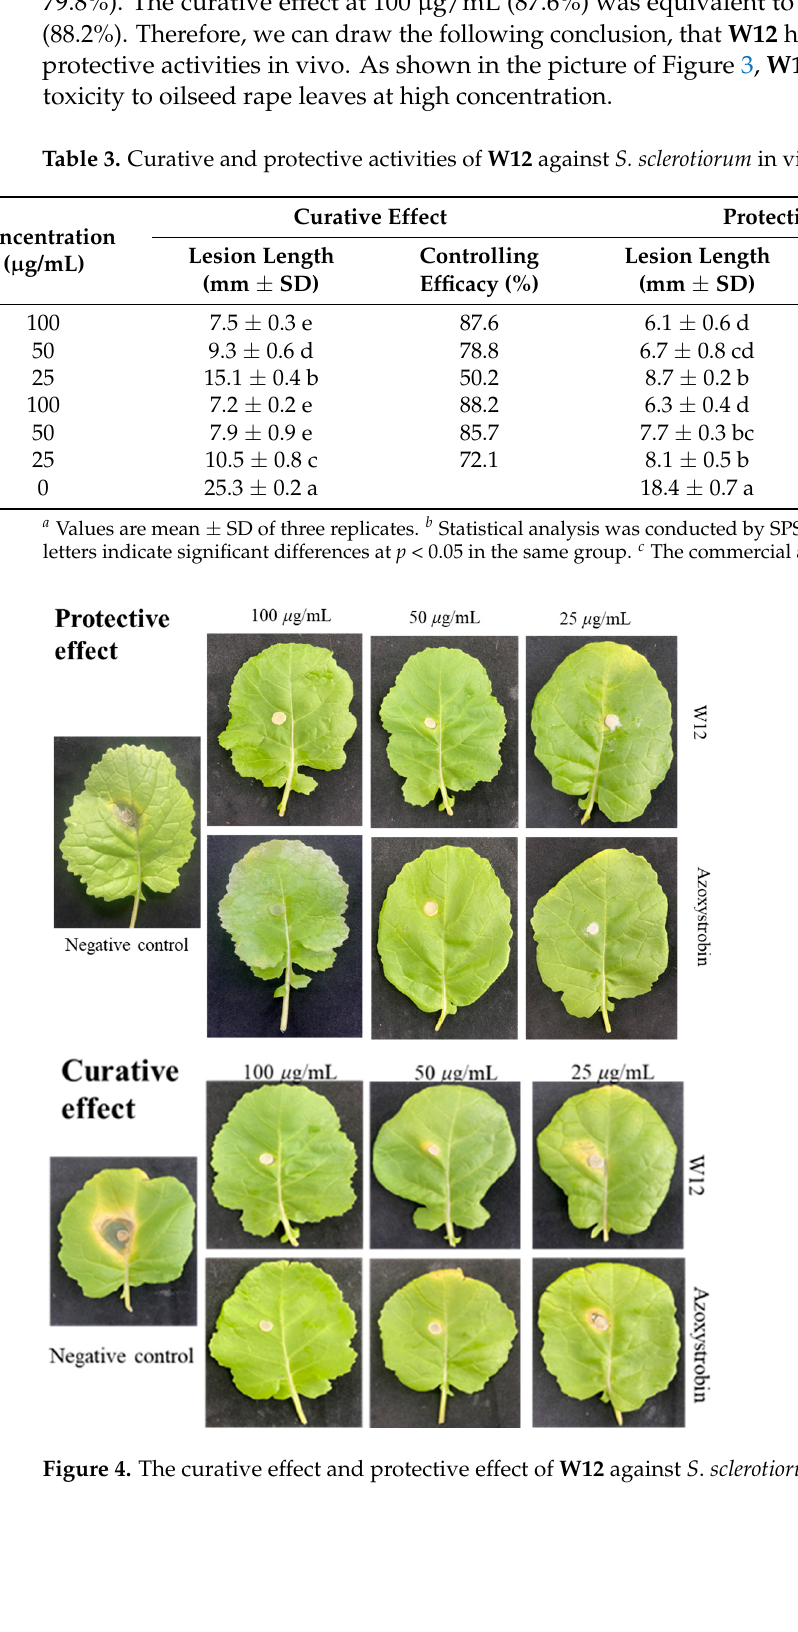
Figure 3. Antifungal activities of W12 against S. sclerotiorum (Ss) and Phomopsis sp. (Ps) in vitro.